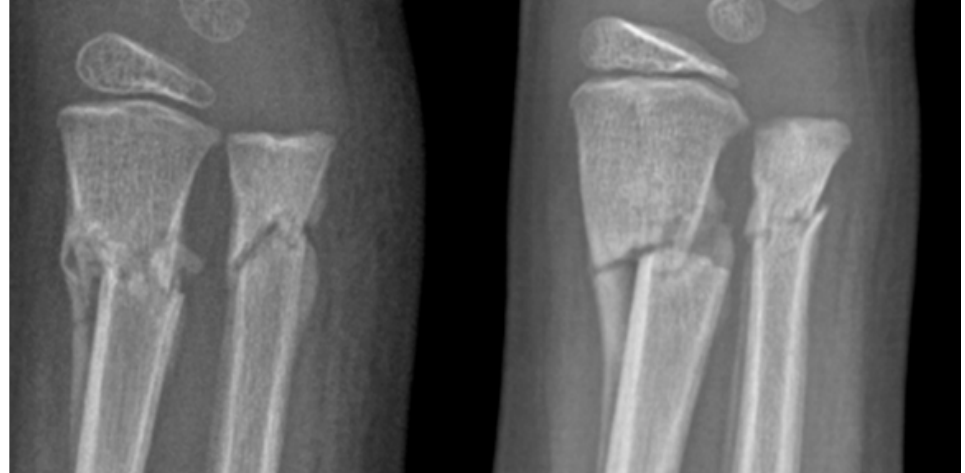
Figure 2. Image presenting a 1/3 distal both-bone forearm fracture of two 6-year-old patients that underwent close reduction. X-ray evaluation at 3 weeks is shown. Left image —6-year-old—control group (no supplements)—27 ng/mL vitamin D. Right image —6-year-old—study group (supplements)—26 ng/mL vitamin D. More bony callus can be seen on the right image .